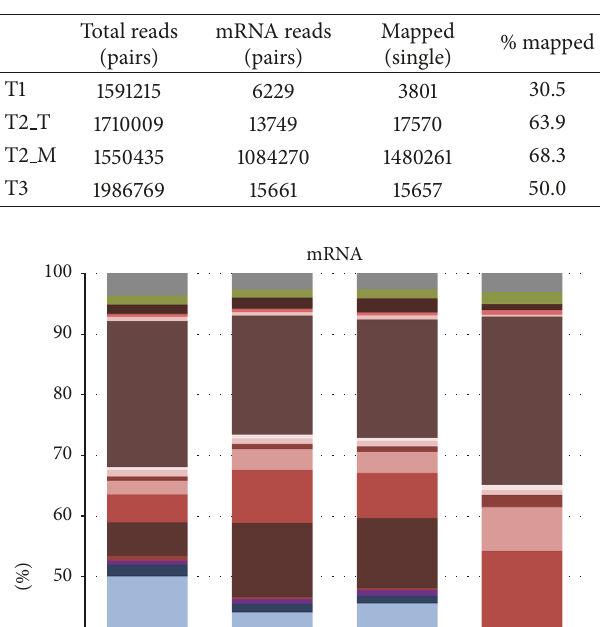
Table 2: Sequencing, assembly, and mapping information of the samples.